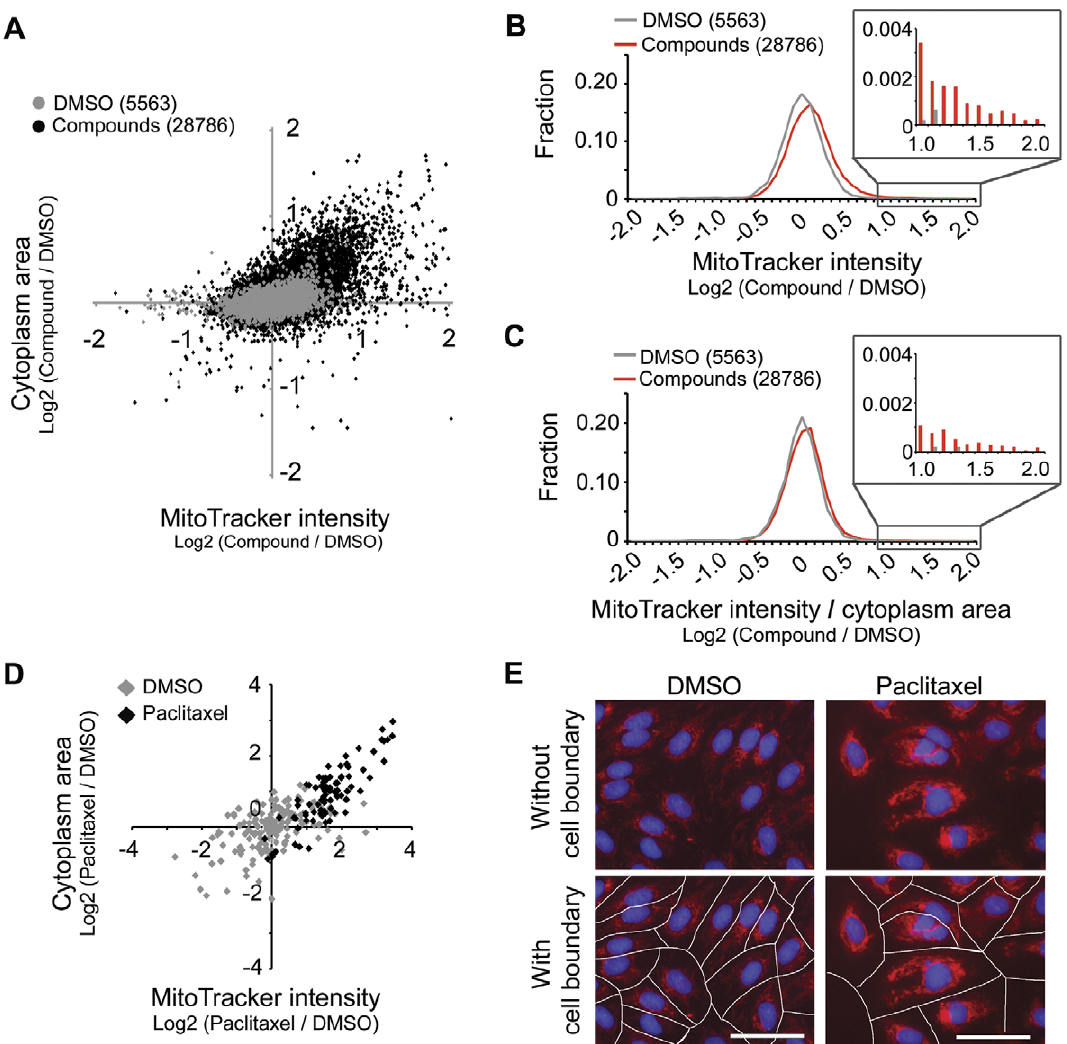
Figure 2. The relationship between mitochondrial content and cell size revealed through 28,786 chemical perturbations. ( A ) MitoTracker intensity per cell versus cytoplasm area per cell for each compound relative to DMSO, reported as the median value across the population of cells in an image. The median values were averaged per compound across biological duplicates and represented by a dot. ( B ) Frequency distribution of (MitoTracker intensity) per cell. ( C ) Frequency distribution of (MitoTracker intensity/cytoplasm area) per cell. ( D ) MitoTracker intensity versus cytoplasm area for 4.6 m M paclitaxel treatment. Each dot represents one cell in an image. ( E ) Images of DMSO and paclitaxel treated HUVEC stained with Hoechst (blue) and MitoTracker (red). White lines define derived cell boundaries. Scale bar: 50 m m.